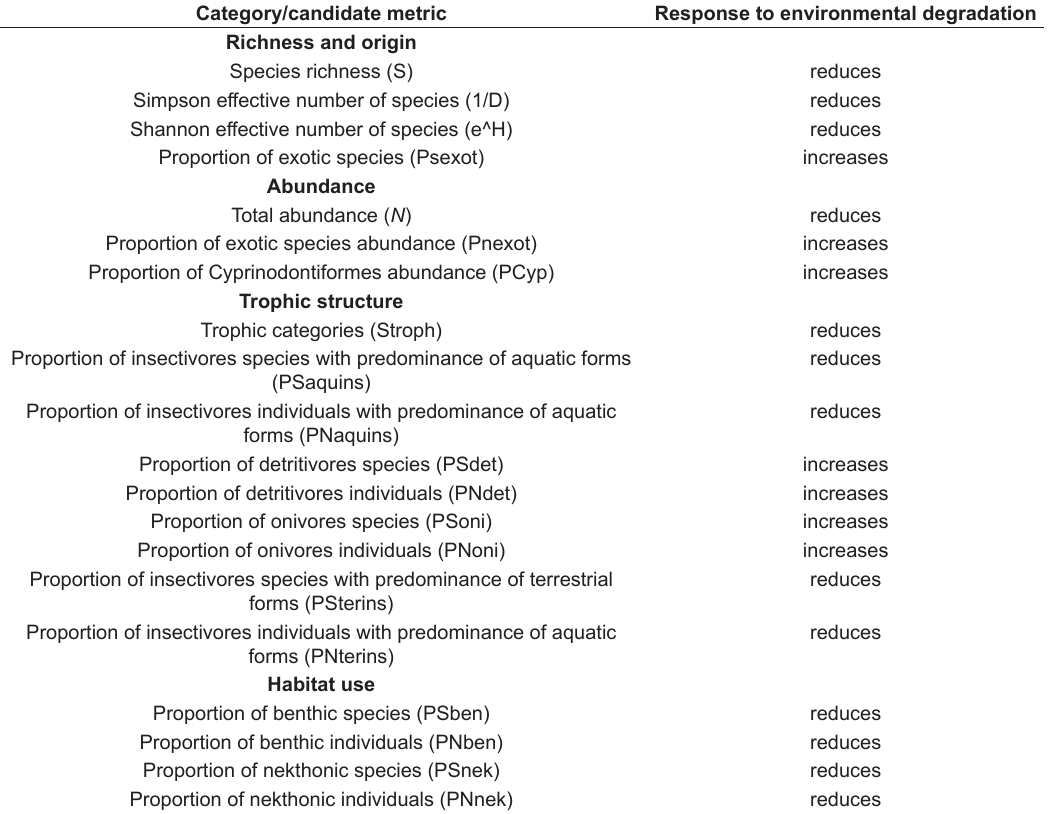
Table 3. Candidate metrics for the index of biotic integrity and the expected response to an increase in environmental degradation.